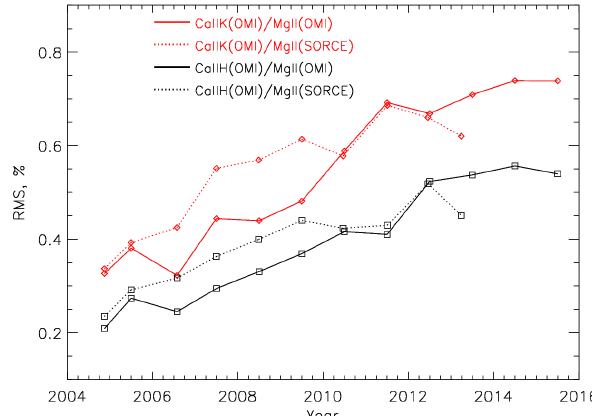
Figure 18. Time-binned (yearly) RMS of the ratios of the solar in- dices derived from the VIS and UV1